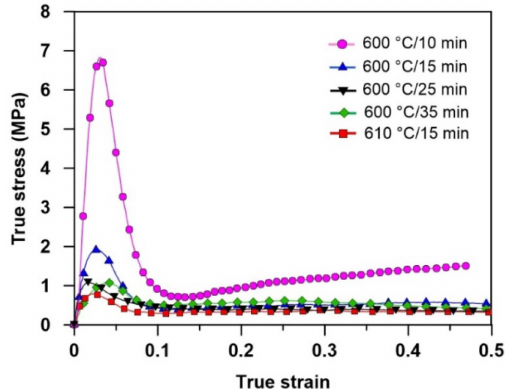
Figure 16. Stress-strain curves of strain induced melt activation (SIMA) processed samples with different initial